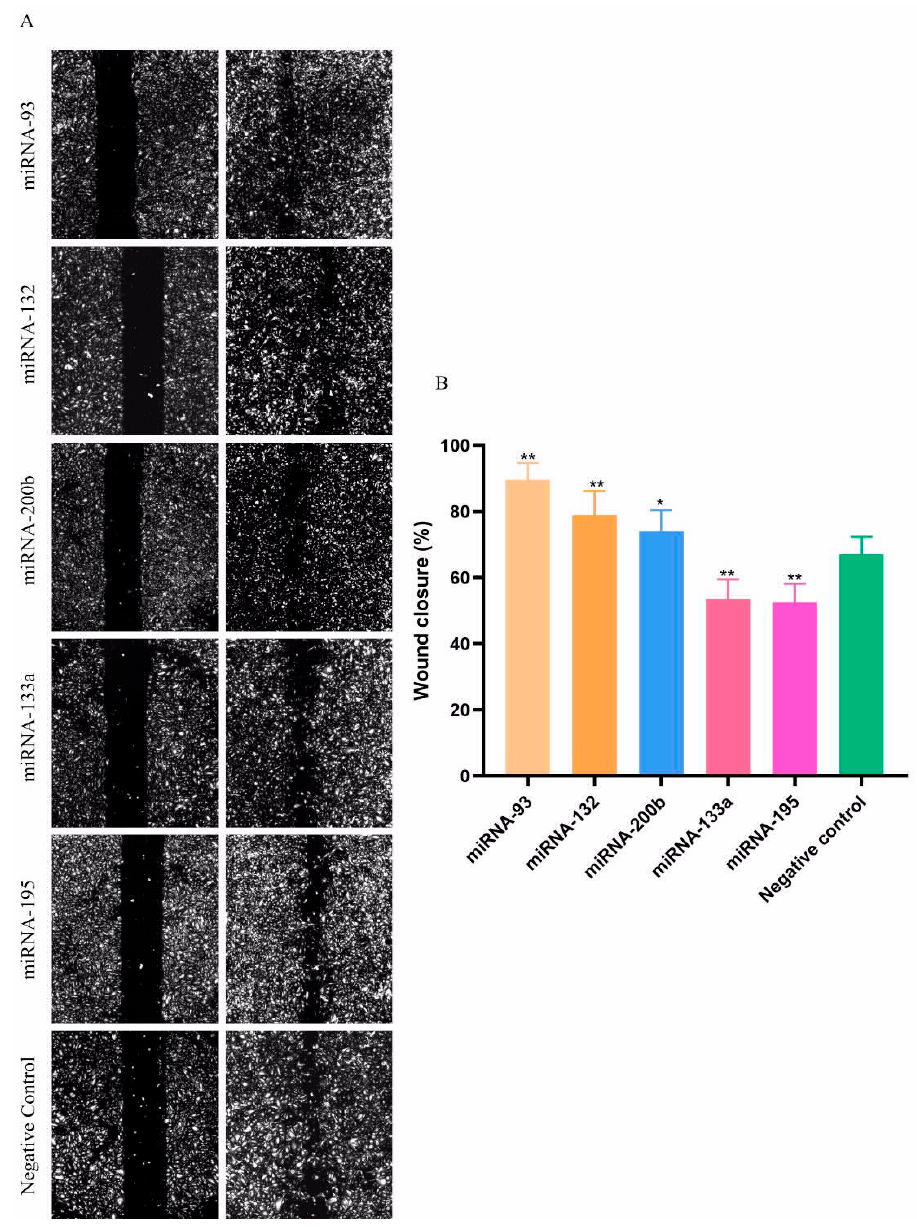
Figure 8. Unchanged expression of miRNAs may still influence HUVEC migration. ( A ) microscopy images of HUVECs migration after transfection with the 5 miRNAs. ( B ) The wound closure (%) of HUVECs after transfected with the 5 miRNAs. * p < 0.05, ** p < 0.01. All experiments were performed independently three times.